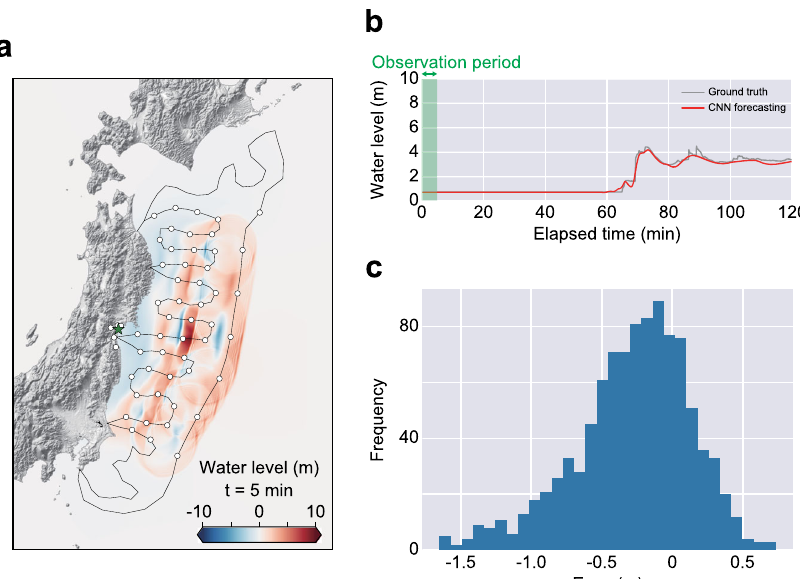
Fig. 3 Application of the trained convolutional neural network (CNN) to 1000 test cases (5-min offshore and geodetic observations). a Observation points and a snapshot of tsunami propagation at 300 s for a simulated test scenario. The location of the observation points as inputs for the CNN are illustrated as circles. The forecasting site is represented with the green star. b Result of tsunami inundation forecasting with the CNN at the forecasting site with the ground-truth simulation result. c Error distribution of the maximum tsunami amplitude at the forecasting site for 1000 test scenarios.